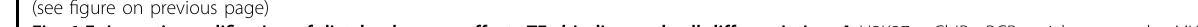
Fig. 6 Epigenetic modi fi cation of distal enhancers affects TFs binding and cell differentiation. A H3K27ac ChIP-qPCR enrichment at the MYB promoter and enhancers in K562 cells treated with hemin to induce erythroid differentiation. B , C GATA1 ( B ) and TAL1 ( C ) ChIP-qPCR enrichment at the MYB promoter and enhancers in K562 cells co-transfected with the indicated dCas9 p300 core and two gRNAs targeted to the each MYB promoter and enhancer region. dCas9 p300 Core (D1399Y) contained a nonfunctional residue substitution at the acetyltransferase domain and was used as a negative control. D K562 cells co-transfected with the indicated dCas9 p300 Core fusion protein and two gRNAs targeted to the − 34k region were treated with hemin for indicated times, then MYB mRNA levels were determined using RT-qPCR. E Model of the dynamic long-range interaction during differentiating of human leukemia K562 cells. Distal cis-regulatory elements ( − 34k and − 88k regions) enriched for activating epigenetic modi fi cation H3K4me1 and H3K27ac, and transcription factors containing GATA1 (orange ovals), TAL1 (violet rectangles) and c-Jun (green diamonds), allowing for high-level expression of MYB . During differentiation, intergenic transcription factor occupancy decreases at the cis-regulatory elements, leading to a destabilization of the DNA-looping and a dramatic decrease of MYB transcription, allowing cells to terminally differentiate. Data are represented as mean ± SD of three independent experiments, and P values are calculated using Student ’ s t -test (* P < 0.05; ** P < 0.01; *** P < 0.001) in A – D